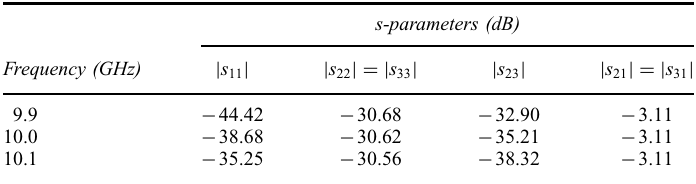
TABLE I Exact Values of the s -parameters in the Desired Frequency